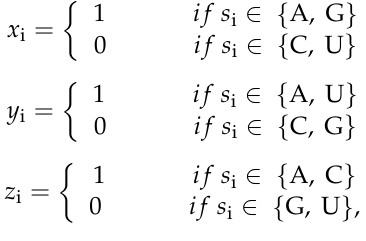
Figure 1. Representation of RNA sequences using different encoding schemes as input to the proposed approach. ( a ) shows the circular representation of RNA sequence. ( b ) shows circular encoding considering every possible combination of four nucleotides bases, and four nucleotides bases yield 16 possible configurations, as shown. ( c ) shows one-hot encoding. ( d ) shows the encoding of input sequence based on nucleotide chemical proper- ties.